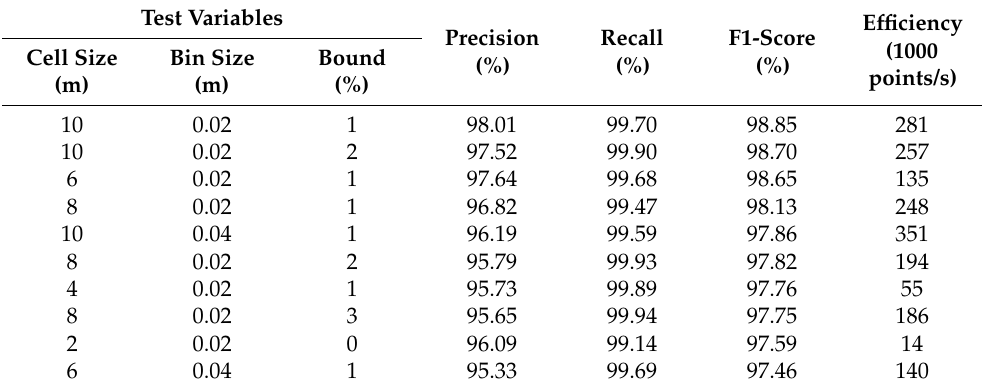
Table 3. Top 10 combinations of parameters for the seafloor segmentation with Marco dataset # 1 and 2.